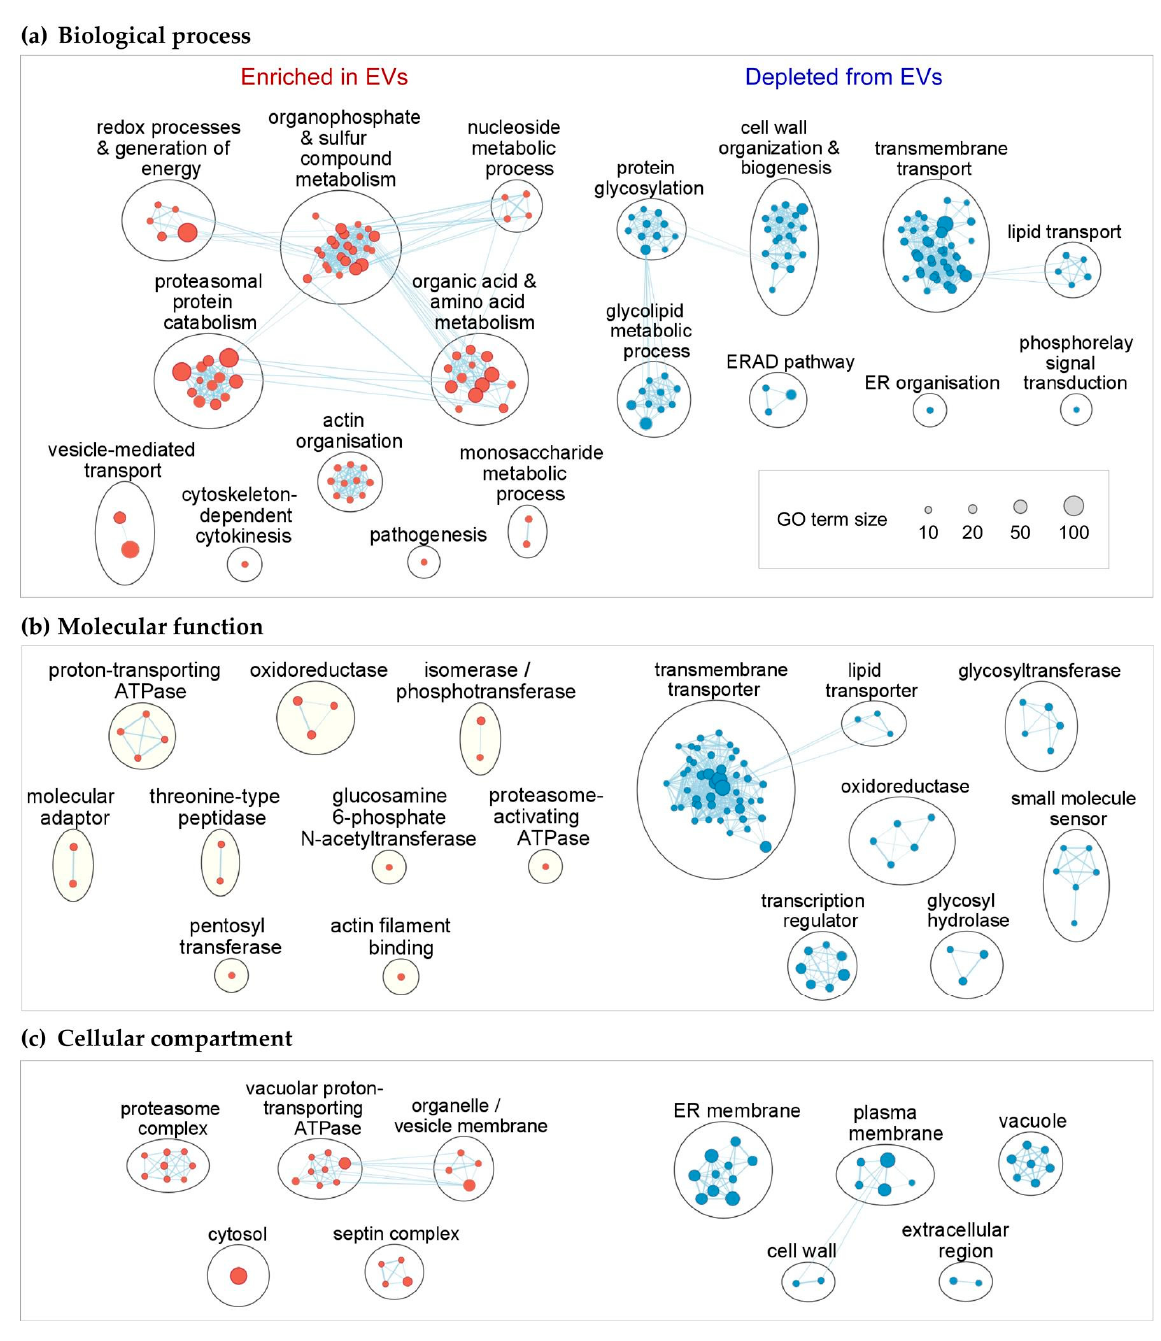
Figure 5. Gene ontology (GO) term analysis of mRNAs differentially loaded into EVs. Biological process ( a ), cellular compartment ( b ), and molecular function ( c ) GO terms significantly overrepresented (g:SCS padj < 0.05) in sets of transcripts enriched (red clusters; n= 748, baseMean ≥ 10, log2 fold change ≥ 1, padj < 0.01) and depleted from EVs (blue clusters; n= 1113, baseMean ≥ 10, log2 fold change ≤ − 1, padj < 0.01).